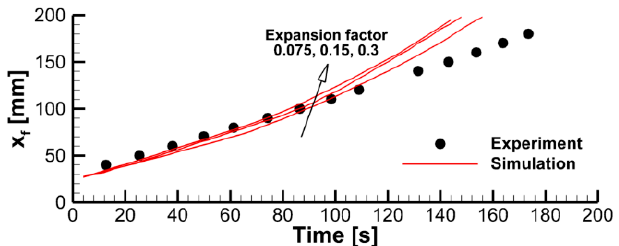
Figure 17. Pyrolysis front coordinate vs. time. Predictions obtained in coupled simulations with three values of the expansion factor are compared with the experimental data.